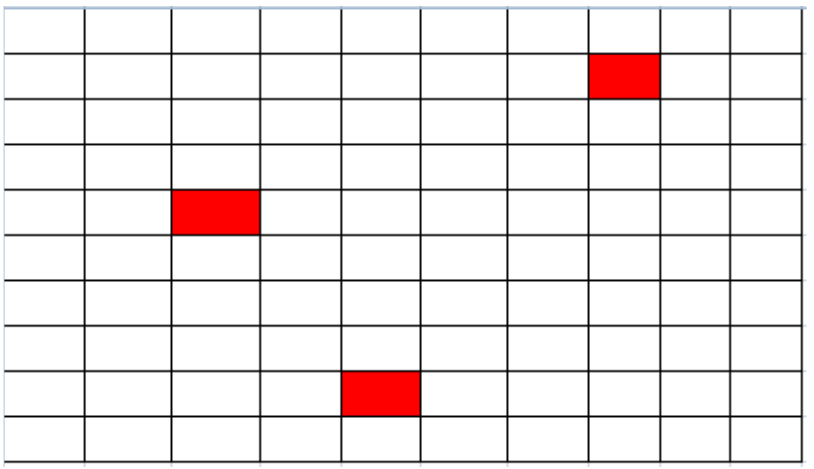
Figure 7. Simulation environment state with 3 apples.